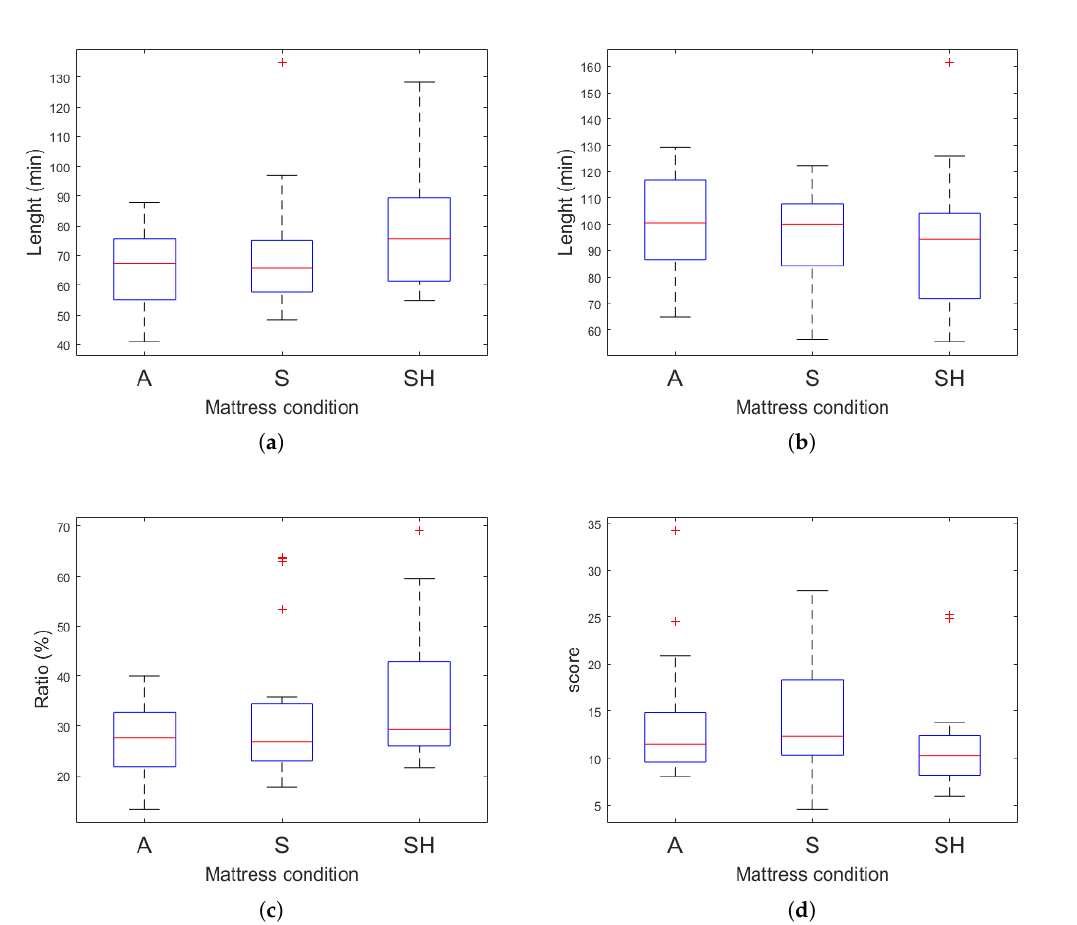
Figure 8. A box plot of the ( a ) duration of REM sleep obtained from the hypnogram estimated via EEG under different mattress conditions, ( b ) duration of Deep sleep obtained from the hypnogram estimated via EEG under different mattress conditions, ( c ) ratio of REM sleep to Non-Rem sleep (RNR) from the hypnogram estimated via EEG under different mattress conditions and ( d ) stage shift index (SSI) obtained from the hypnogram estimated via EEG under different mattress